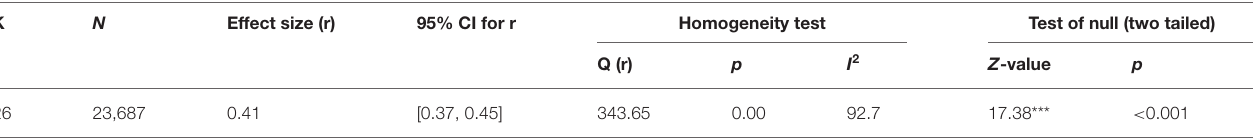
TABLE 2 | Random-model of the correlation between alexithymia and